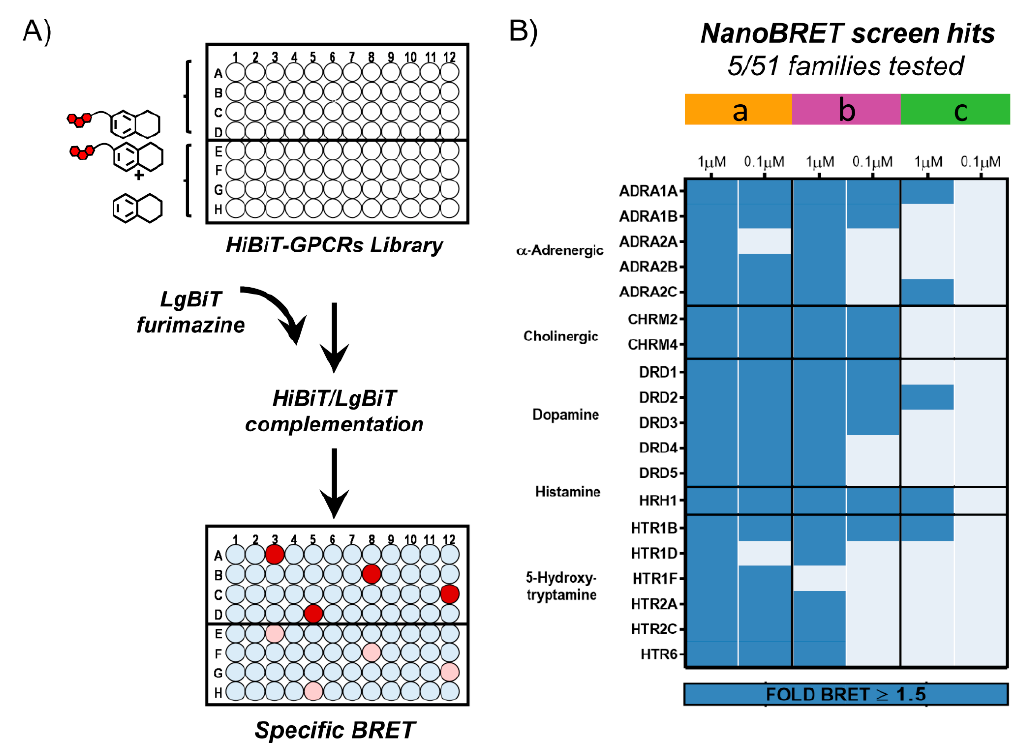
Figure 4. NanoBRET screen of Clozapine tracer candidates. ( A ) Illustration of the NanoBRET screening strategy for revealing the binding profile of fluorescent tracer candidates. Duplicates of cells transfected with 48 different HiBiT-GPCRs constructs per plate were treated with a fluorescent tracer either alone or in the presence of competing parental compound. Following complementation with purified LgBiT and measurement of BRET, specificity of interactions was evaluated through a decrease in BRET due to competitive displacement of the bound tracer by excess parental compound. Background BRET is shown in light blue, specific BRET is shown in red and a decrease in BRET due to competitive displacement is shown in lighter pink. ( B ) Binding profile of Clozapine tracer candidates. Modification sites are shown in Figure 3. NanoBRET screen across 184 HiBiT-GPCRs from 51 families revealed specific interactions ( ≥ 1.5-fold response) with GPCRs from five different families. Clozapine-a-2-NB590 had the broadest binding